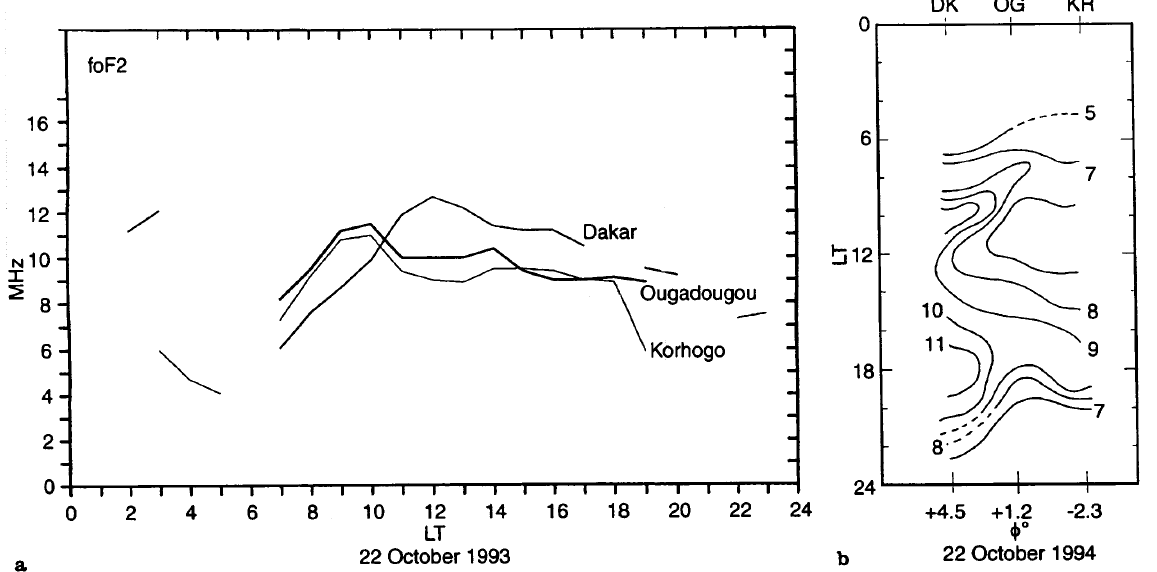
Fig. 4. Example of crest-type event for 22 October 1993, morning and afternoon northern crest events. a f oF2(UT) curves, b corresponding f oF2 contour chart